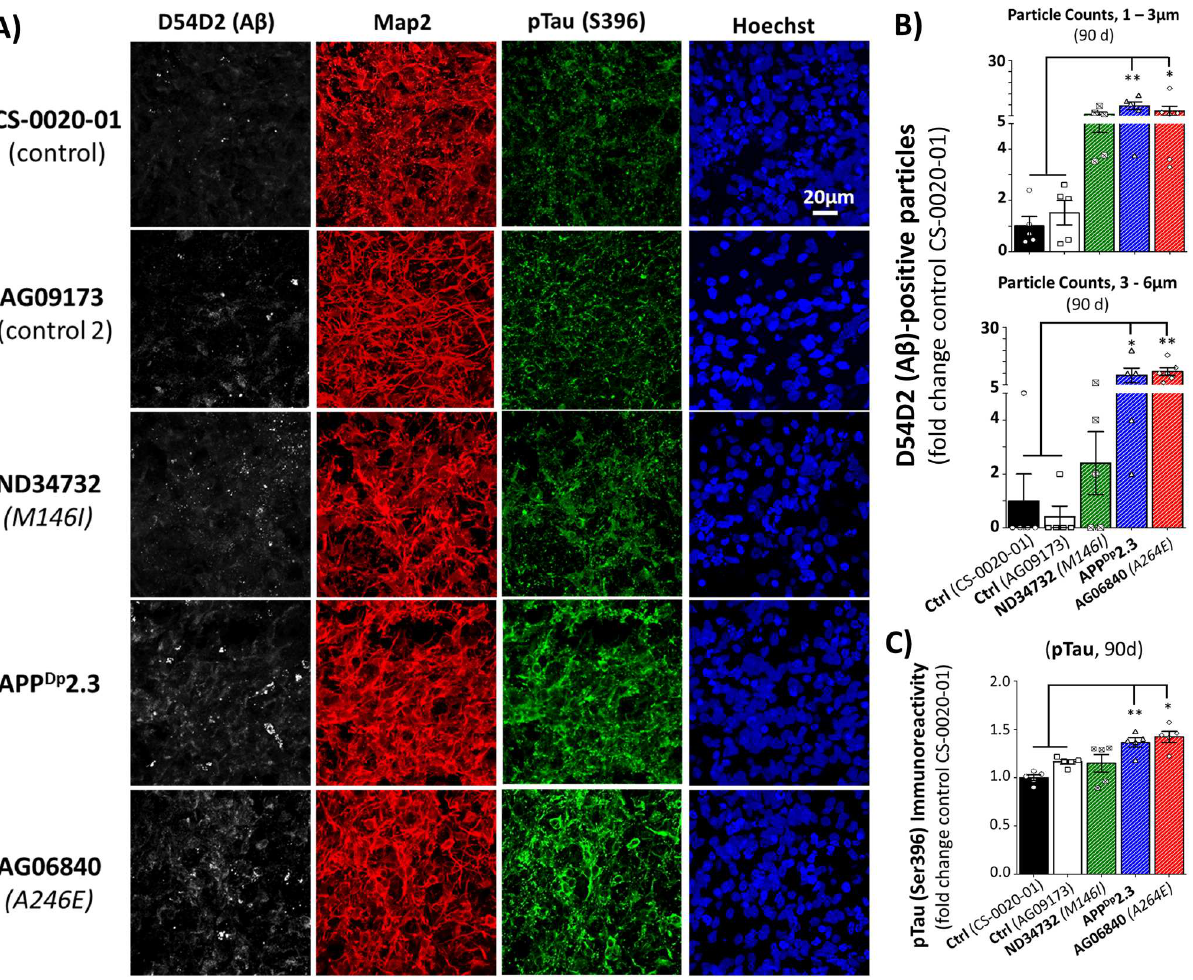
Fig 2. Organoidscreatedfrom different linesof AD patientiPSCs exhibitAD phenotypes. (A) Tissue sectionsfromfAD ( APP Dp 2-3, ND34732, AG068840) and control(Ctrl;CS-0020-01, AG09173) organoidswere processedfor immunoreactivity against A β (D45D2, white),MAP2 (red),and pTau (S396,green)and labeledwith the nuclear dye Hoechst.(B) Quantification of A β immunoreactivity in fAD and Ctrlorganoidsfollowing 90 days of culture.Values betweenthe two control lines did not significantlydiffer. Numberof A β -positive aggregates in two size classes (ParticleCounts):one-way ANOVA with post-hocTukey’s multiplecomparisons test; F (4,21)= 6.15, ** p = 0.0019,R 2 = 0.5396(1–3 μ m); F (4,21)= 7.95, *** p = 0.0005,R 2 = 0.6024(3–6 μ m).(C) Quantification of the average intensityof pTau Ser396immunoreactivityas a fold change of Ctrlin fAD and Ctrlorganoidsfollowing 90 days of culture.Values betweenthe two controllines did not significantlydiffer. (Each data point represent one organoid). One-way ANOVA with post-hocTukey’s